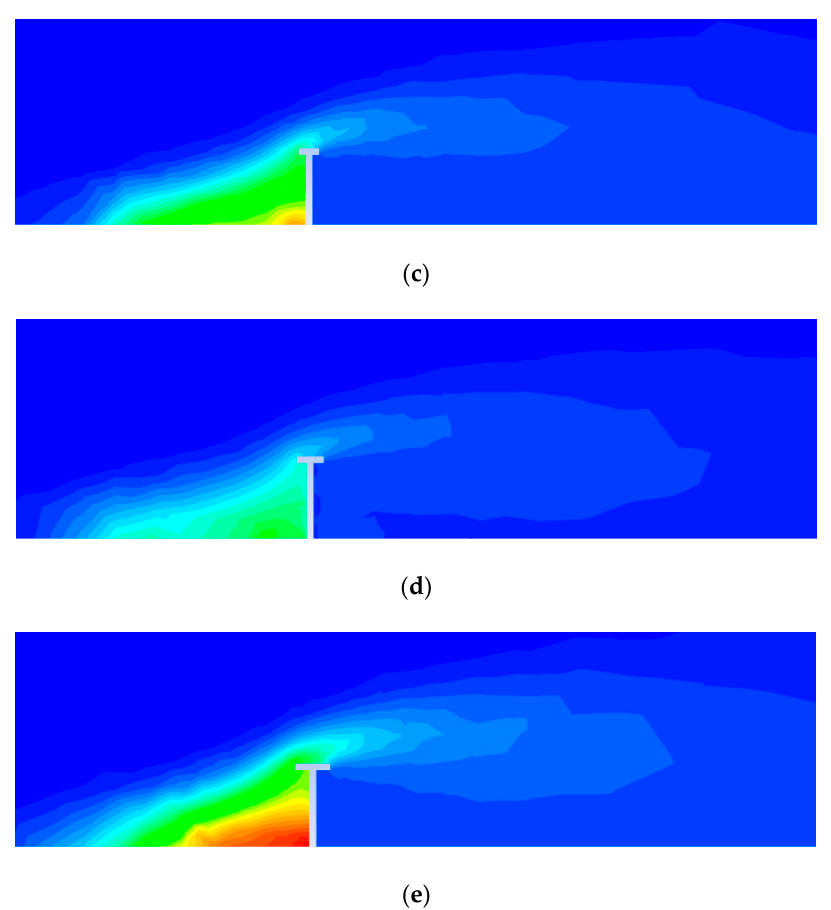
Figure 9. Contours of CO molar concentration for different barrier shapes (H = 6 m). ( a ) Base case; ( b ) case 1; ( c ) case 2; ( d ) case 3; ( e ) case 4.